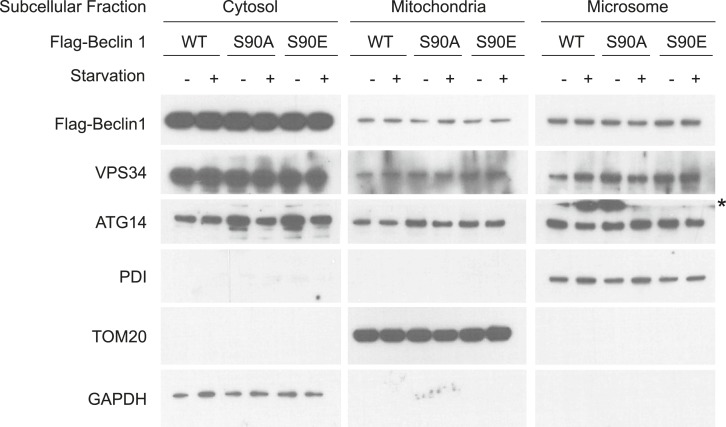
Effects of Beclin 1 S90 phosphorylation o on subcellular localization of the Beclin 1/VPS34/ATG14 complex.Subcellular localization of Beclin 1, VPS34, and ATG14 in normal media or after starvation for 2 hr in HBSS in beclin 1 shRNA U2OS cells following treatment with 1 μg/ml doxycycline for 4 days and transfection with indicated shRNA-resistant Flag-Beclin 1 non-targetable wild-type (WT) or indicated mutant plasmids. Loading controls for the cytosol, mitochondria, and microscome fractions are GAPDH, TOM20, and PDI, respectively. Asterix denotes non-specific signal due to membrane edge artifact.